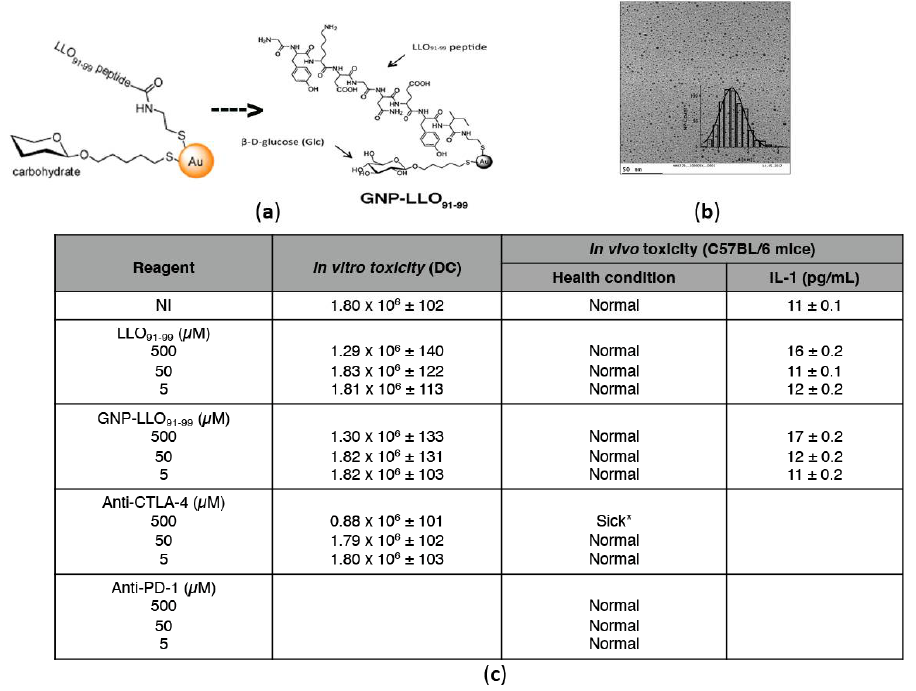
Figure 1. Preparation of GNP-LLO 91–99 nanovaccines, quality, and toxicity controls in vitro and in vivo. ( a ) Schematic representations of GNP-LLO 91-99 nanovaccines and chemical structure showing localization of LLO 91–99 peptide and the carbohydrate, β-D-glucose. ( b ) Transmission electron microscopy (TEM) image (100,000 × ), including the size histogram that shows the spherical shape and nanometric size of the gold core of GNP-LLO 91-99 . ( c ) In vitro toxicities of GNP-LLO 91–99 nanovaccines were explored in MoDCs of healthy donors incubated for 16 h with different concentrations of GNP-LLO 91–99 nanovaccines or LLO peptide, LLO 91-99 (5–500 µM) to examine cell viability with Trypan-blue staining. Results are expressed as the mean of viable cells ± SD. For in vivo analyses, we inoculated mice (12 months old male, n = 5, or female, n = 5) intravascularly (i.v.) with the same concentrations of GNP-LLO 91–99 nanovaccines and LLO 91–99 peptide as in ( a ) (5–500 µM) in C57BL/6 mice for 16 h, examined mice health conditions, and measured IL-1 concentration in mice sera. Experiments were performed five times each. Results are expressed as the mean cytokine concentrations (pg/mL) ± SD. *Sick, refers to animals with hairless and difficulties to move and feed.